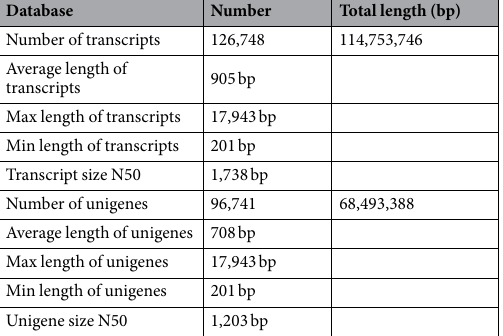
Table 1. Summary of Illumina paired-end sequencing and assembly for D . scandens .